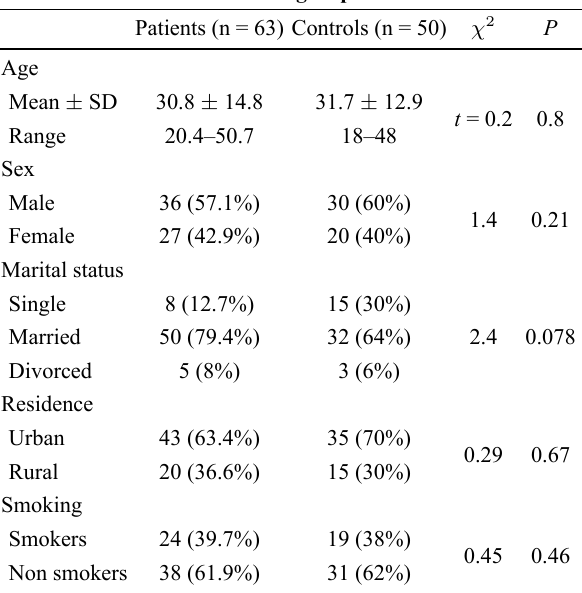
χ 2 , chi-square test of significance. t , Student’s t test of signifi-